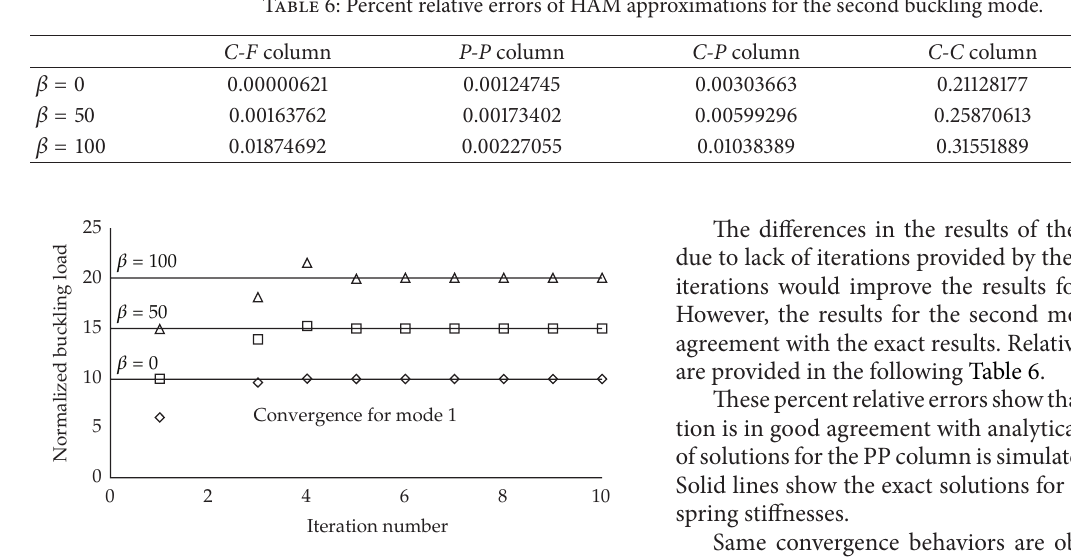
Figure 8: Convergence of solutions through the iterations for the first mode of P-P